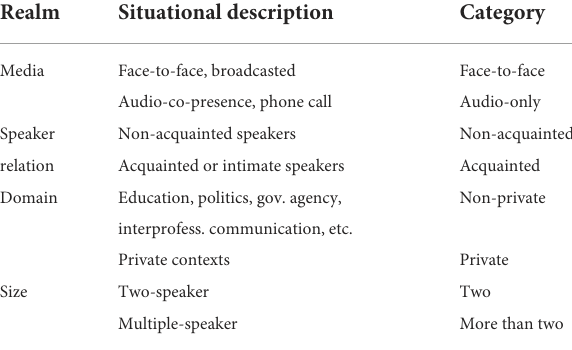
TABLE 2 Project A06: Classification and coding of pre-existing conversation data from the FOLK corpus (Schmidt, 2016) and the Pfeffer-Korpus (Pfeffer and Lohnes, 1984) on the basis of available